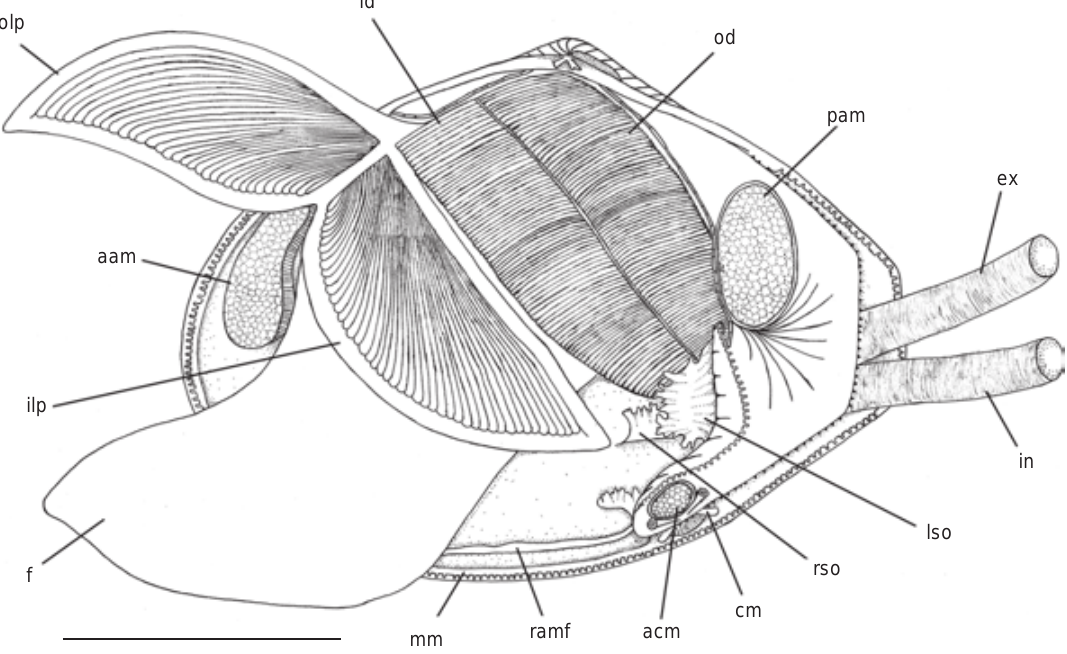
Figure 8. Macoma biota : organs of the pallial cavity viewed from the left side after the removal of the left shell valve and mantle lobe. (aam) anterior adductor muscle, (acm) accessory adductor muscle, (cm) cruciform muscle, (ex) exhalant siphon, (f) foot, (id) inner demibranch, (ilp) inner labial palp, (in) inhalant siphon, (lso) left siphonal organ, (mm) mantle margin, (od) outer demibranch, (olp) outer labial palp, (pam) posterior adductor muscle, (ramf) right additional mantle fold, (rso) right siphonal organ. Scale bar: 1.5